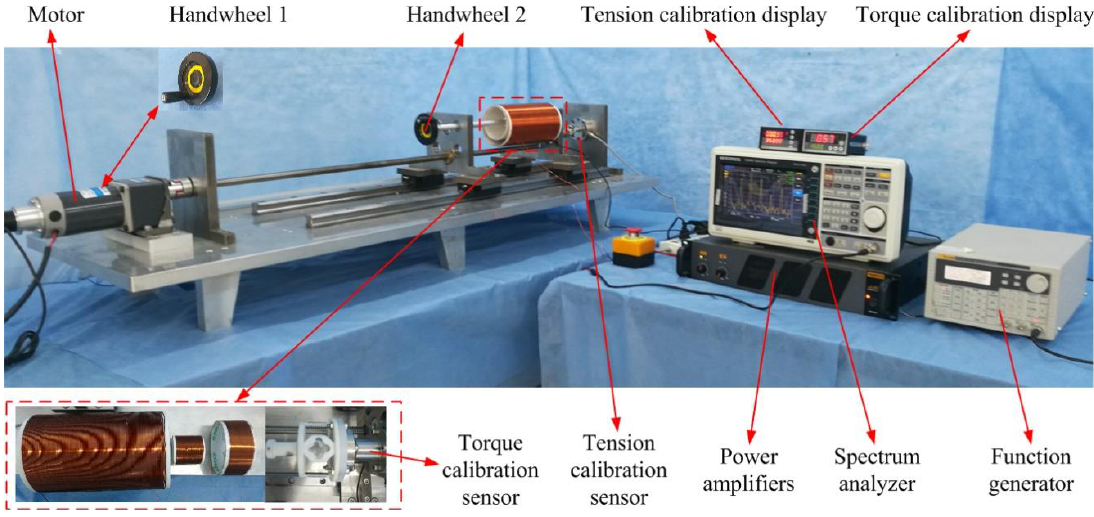
Figure 8. The experiment setup.